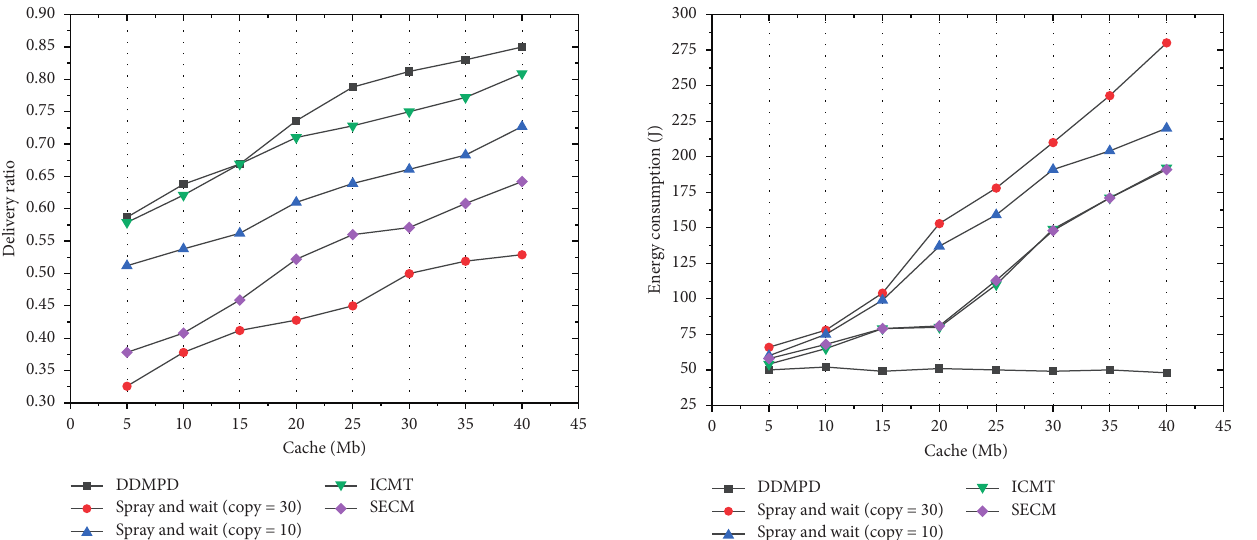
Figure 11: Relationship between the delivery ratio and cache.